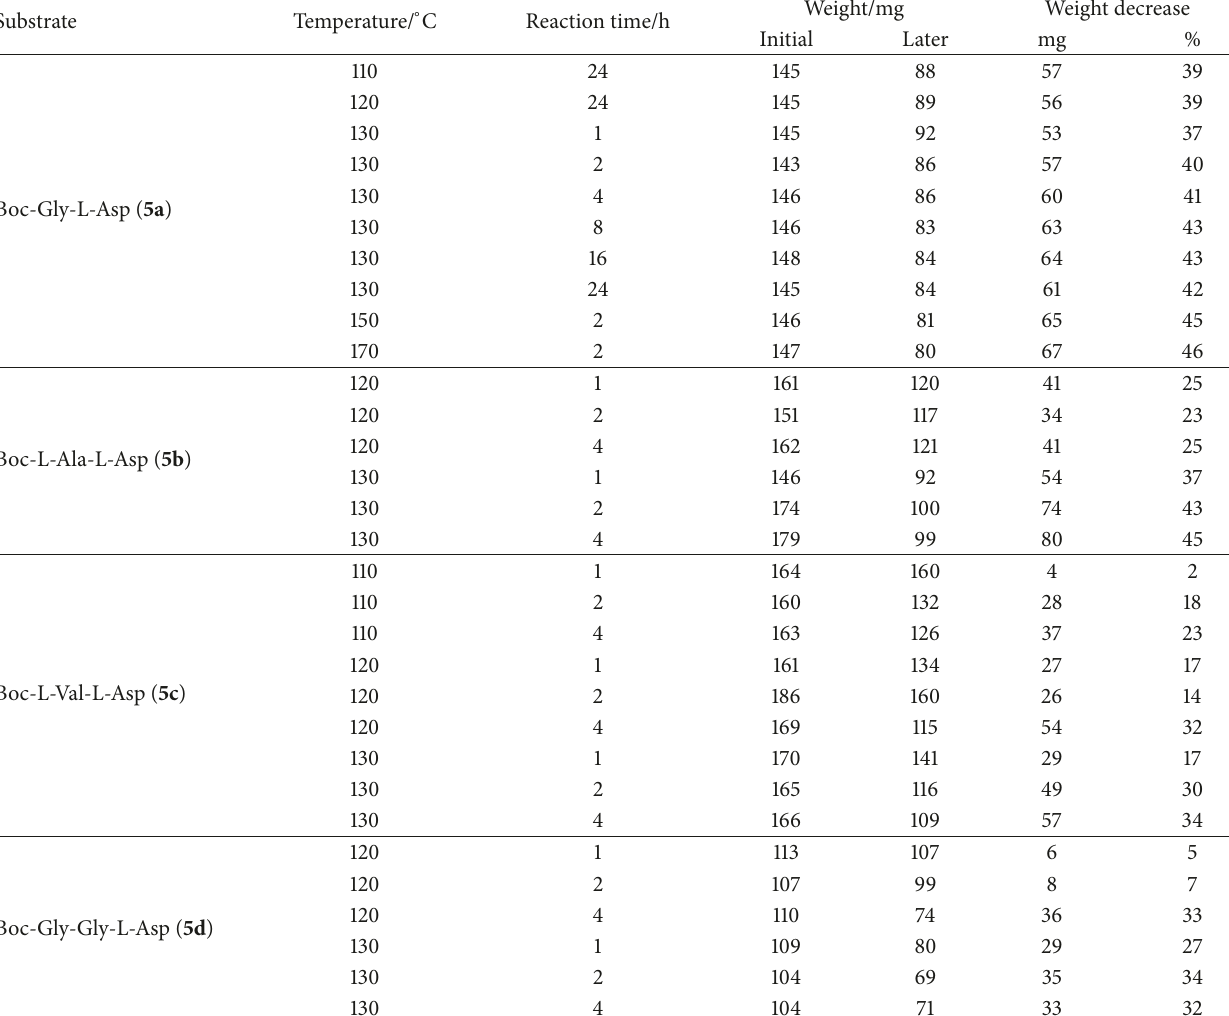
Table 1: Weight decrease in the heating reaction of substrate